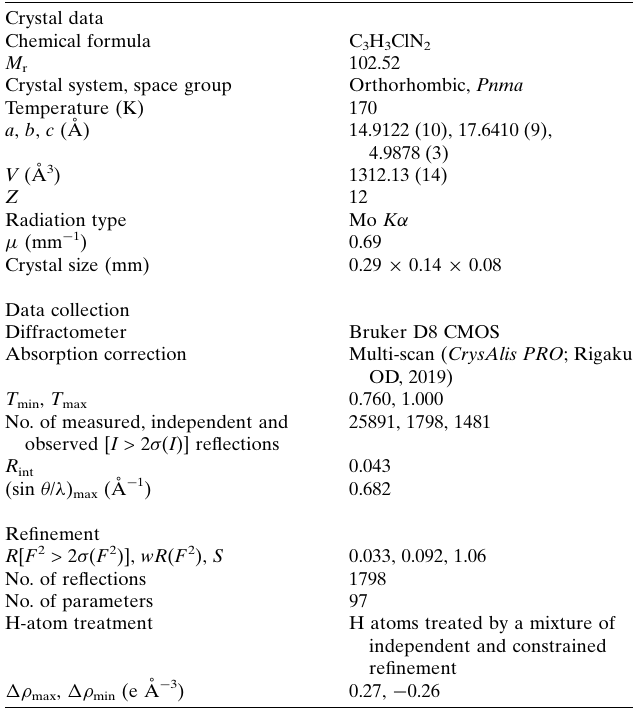
Table 2 Experimental details. Crystal data Chemical